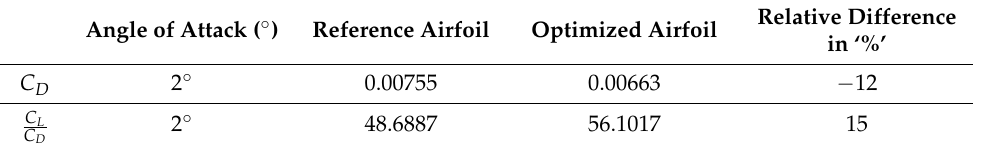
Table 1. Comparison of aerodynamic coefficients of the reference and optimized. Angle of Attack ( ◦